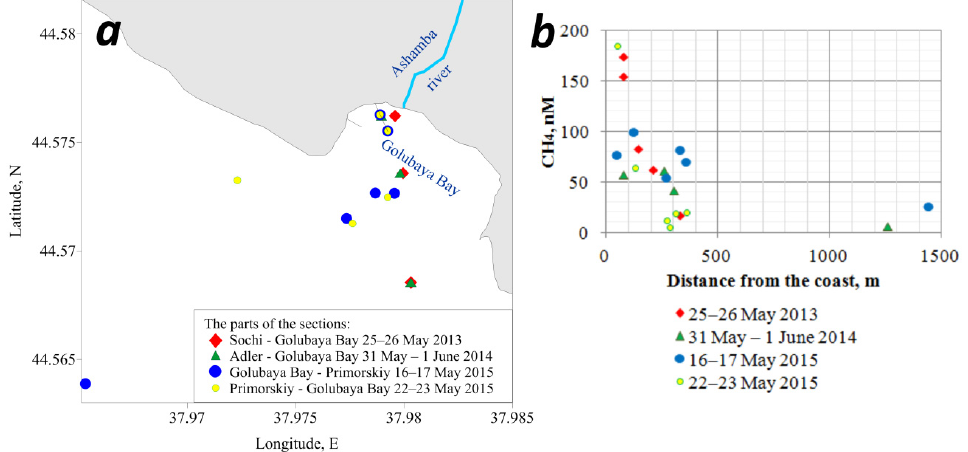
Figure 8. Location of stations ( a ) and methane content ( b ) on the sections at the entrance to Golubaya Bay (2013–2015).